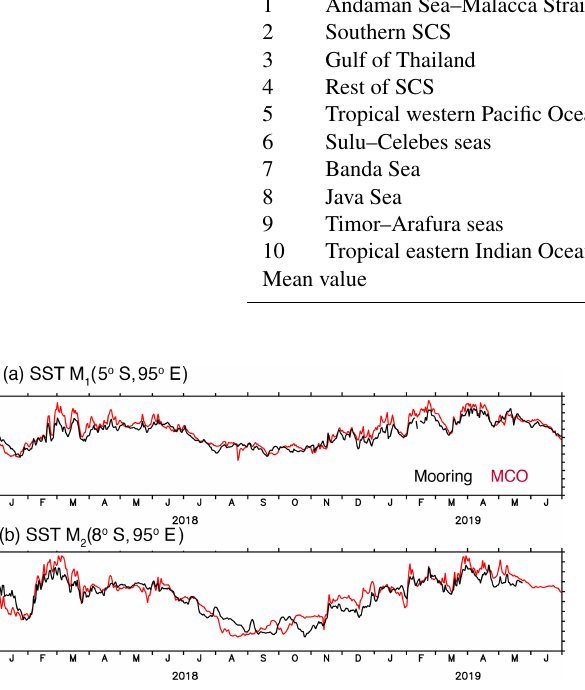
Figure 5. Comparison of daily averaged SST from MCO hindcast and RAMA moored buoys at (a) M 1 and (b) M 2 during the period 1 January 2018 to 30 June 2019.